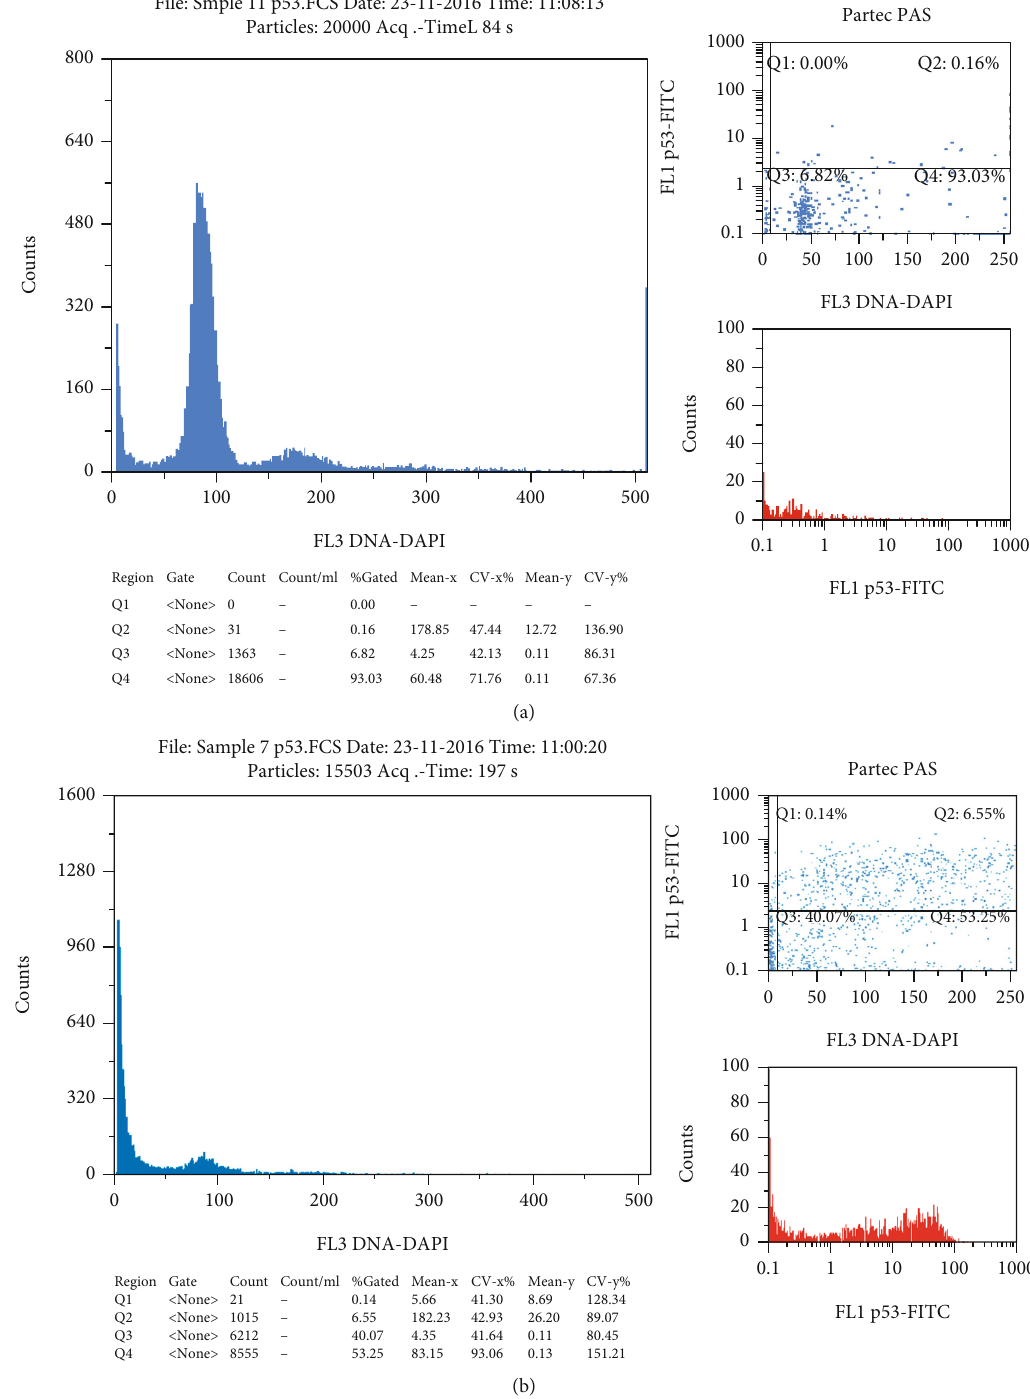
Figure 1: Cytometry result of p53 labeled samples: (a) normal sample with 0.16% of positively labeled cells; (b) abnormal sample with 6.55% of positively labeled